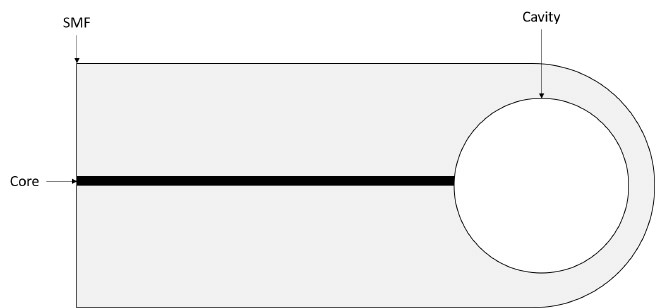
Figure 3. Schematic of an EFPI sensor based on Liao et al. (Adapted from ref.